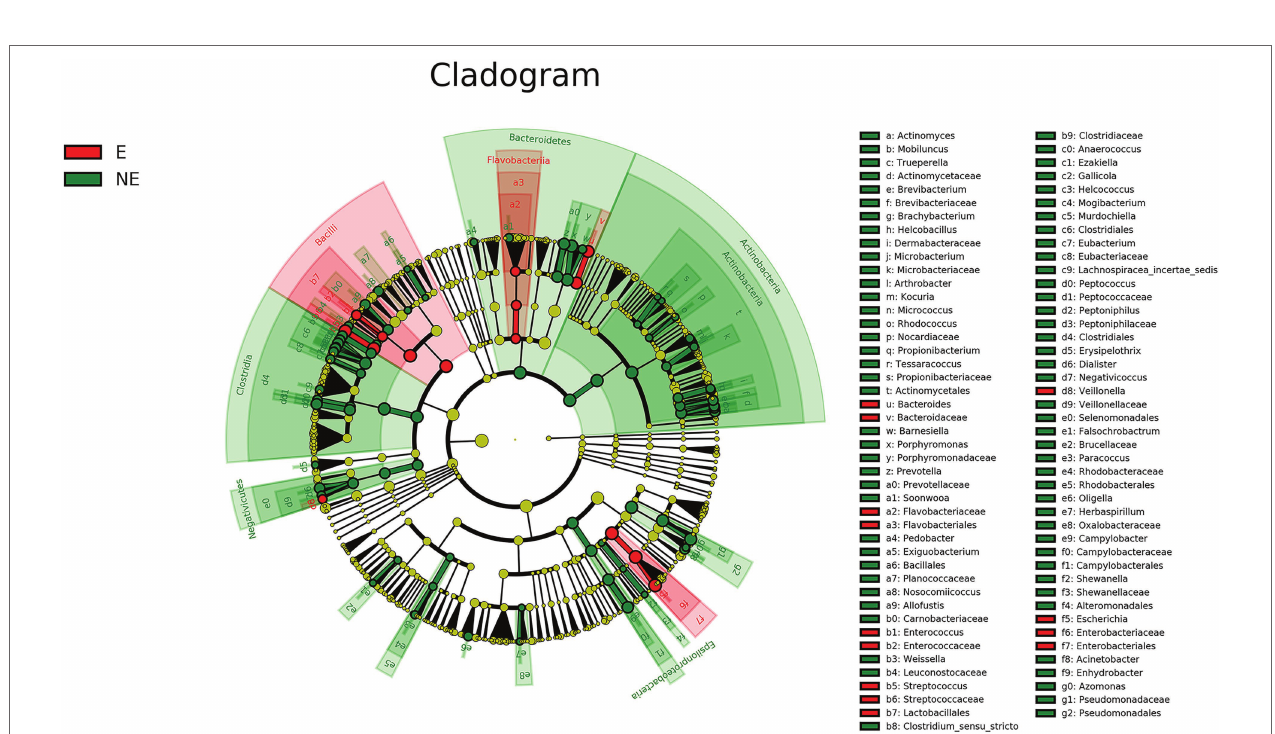
FIGURE 5 | Linear discriminant effect size cluster tree for 16S rRNA gene sequencing analysis. Different colors indicate different groups. Colored notes represent a group, color shading over the notes indicate the significant microbe biomarker in the group causing a significant difference in abundance, and the biomark name is listed in the upper right corner. The yellow notes represent the biomarkers that do not show significant differences in abundance in the